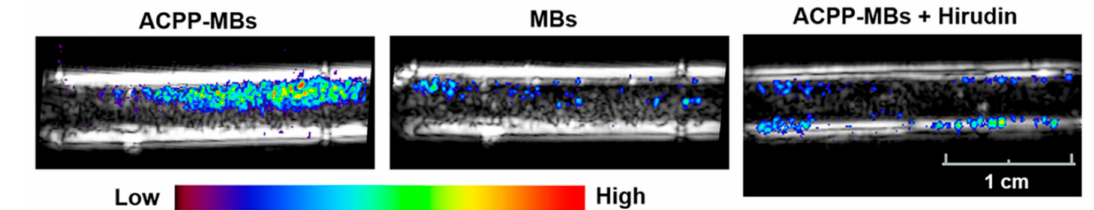
Figure 7. Molecular US imaging of thrombosis. Spatial maps of the molecular US signal color-coded and overlaid on B-mode images acquired at baseline after infusion of MB and washing with saline using targeted MB (left), non-targeted MB (middle), and targeted MB co-injected with hirudin (right). Targeted MB give specific signal only in the presence of thrombin. Reproduced with permission from [97]. Copyright American Chemical Society, 2017.